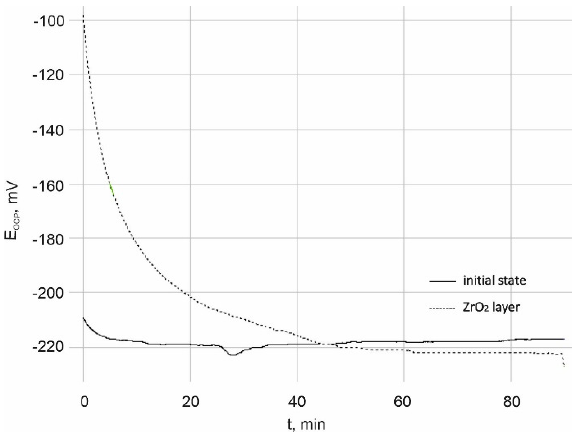
Figure 3. Open circuit potential (E OCP ) time variation.